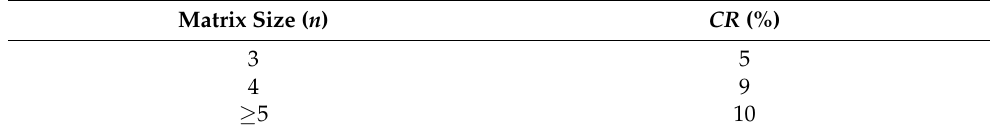
Table 2. Maximum consistency ratio